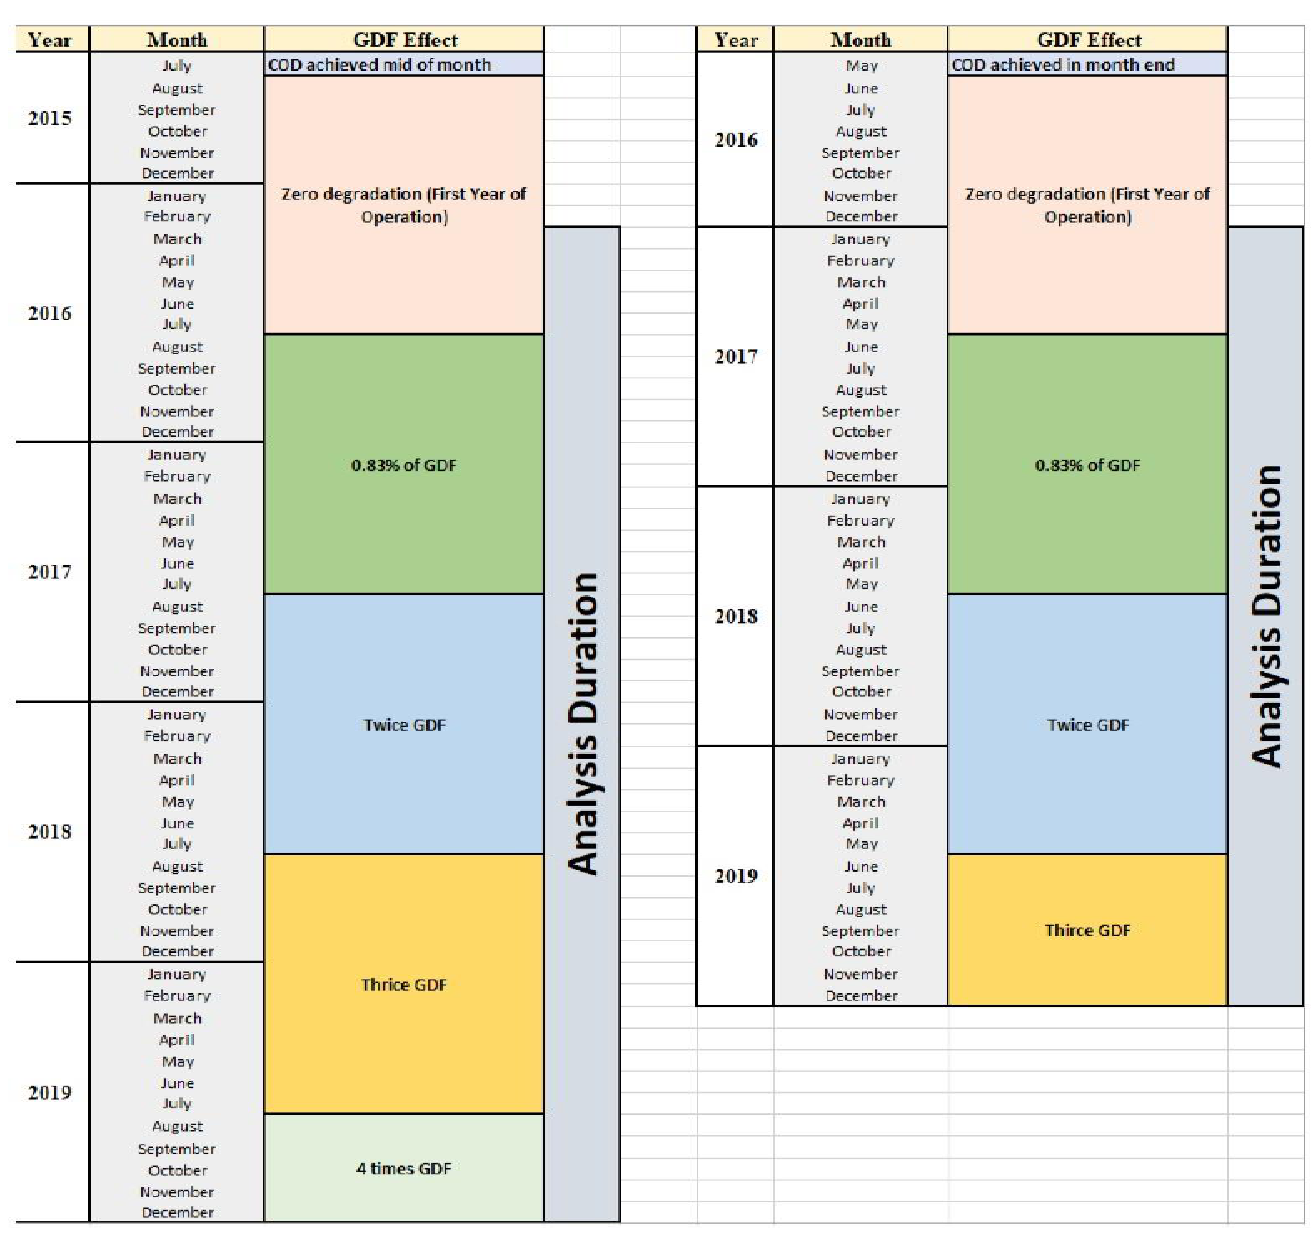
Fig. 10. Analysis duration of QASPP and Crest